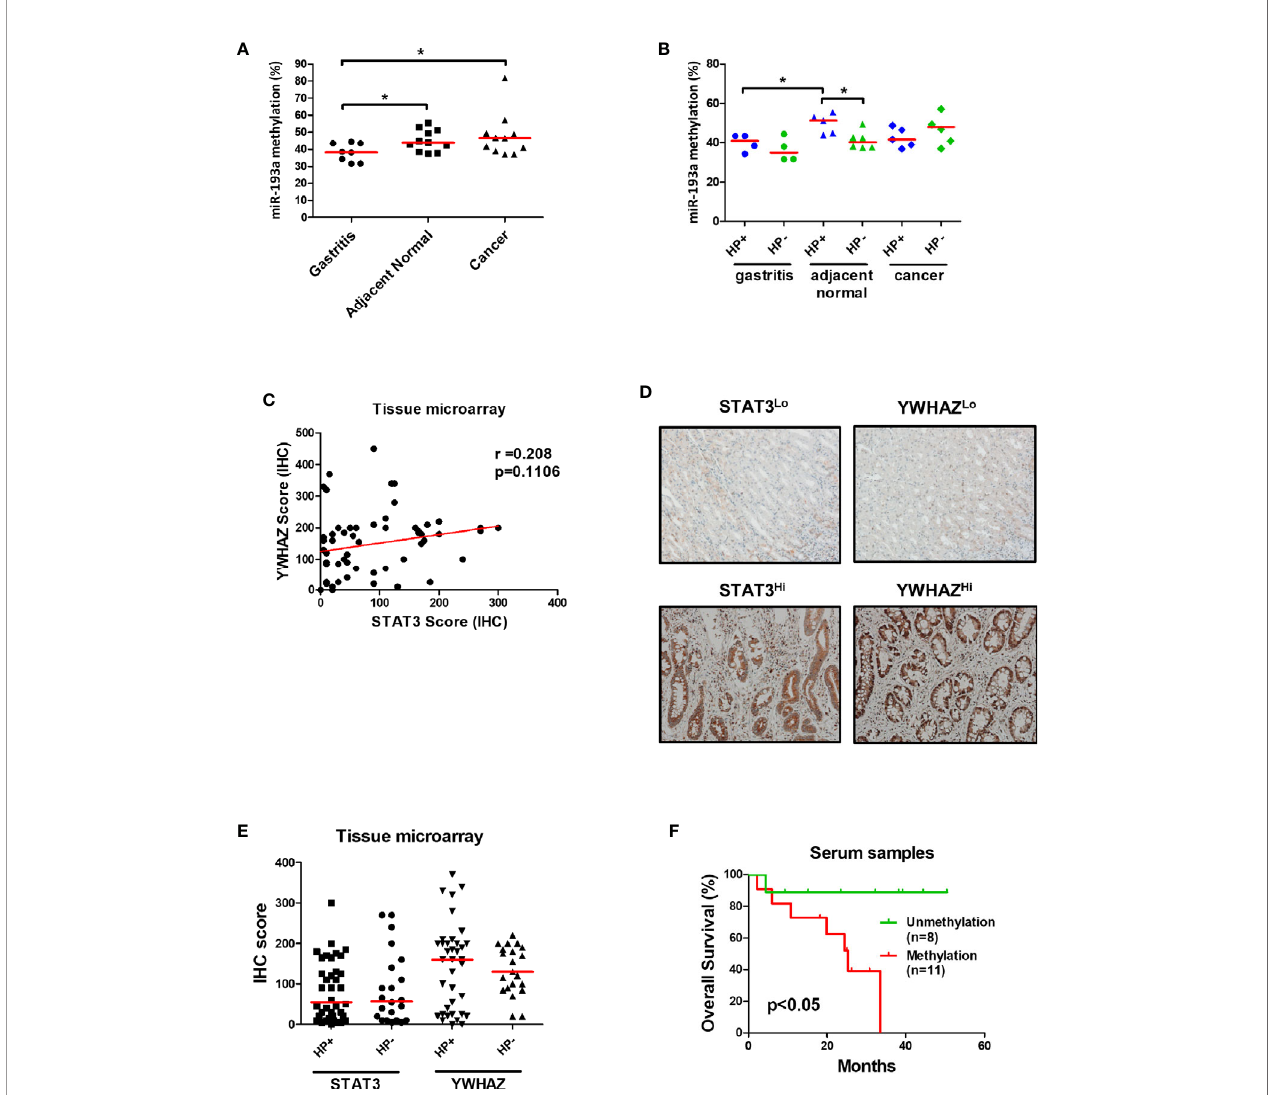
FIGURE 6 | Infection of H. pylori is associated with miR-193a hypermethylation and increased YWHAZ expression in gastric cancer. (A, B) Scatter plot showing miR-193a methylation in patient tissue samples with gastritis (n = 8), and paired tumor adjacent normal and gastric cancer (n = 11). Red lines denote median. Infection of H.pylori is associated higher miR-193a methylation in gastritis and tumor adjacent normal. Immunohistochemistry of STAT3 and YWHAZ in gastric cancer tissue (n = 60) was performed using tissue microarray. (C) Scatter plot showing a positive trend between expression score of STAT3 and YWHAZ. (D) Tissues infected with H. pylori showed a higher expression of YWHAZ than those without H. pylori infection. (E) Representative photos showing low (STAT3 Lo , YWHAZ Lo ) and high (STAT3 Hi , YWHAZ Hi ) expression of STAT3 and YWHAZ in tissue microarray. (F) Kaplan-Meier analysis showed that patients with serum miR- 193a methylation is associated with shorter overall survival as compared to samples without methylation (p <